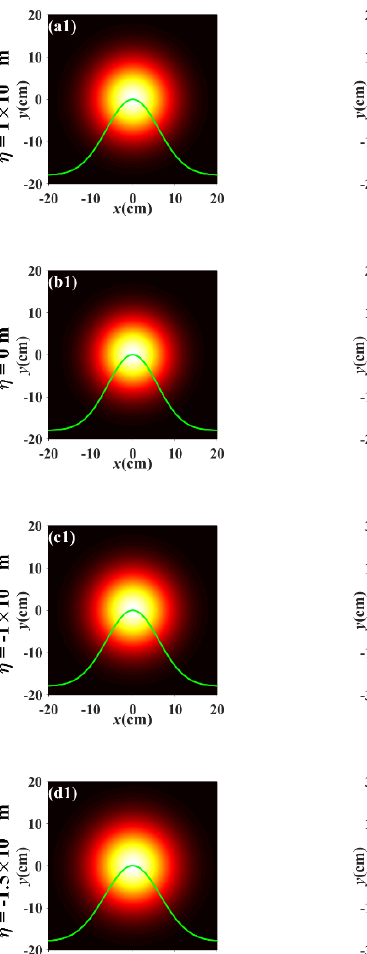
= 5 × 10 − 14 m 3 − α , ξ x = n